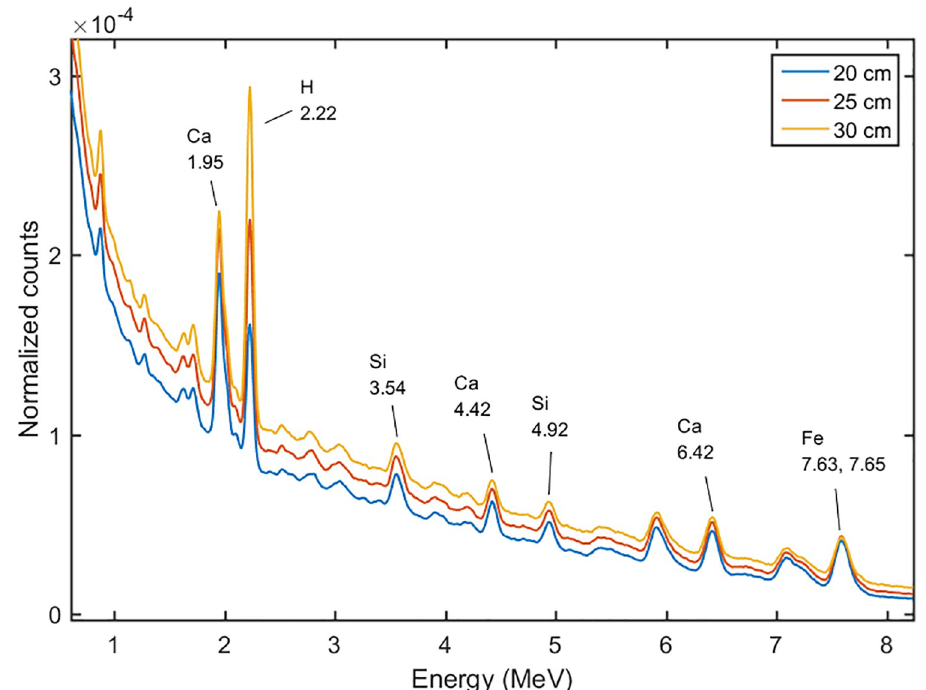
Fig 10. The thermal spectra with different thicknesses.